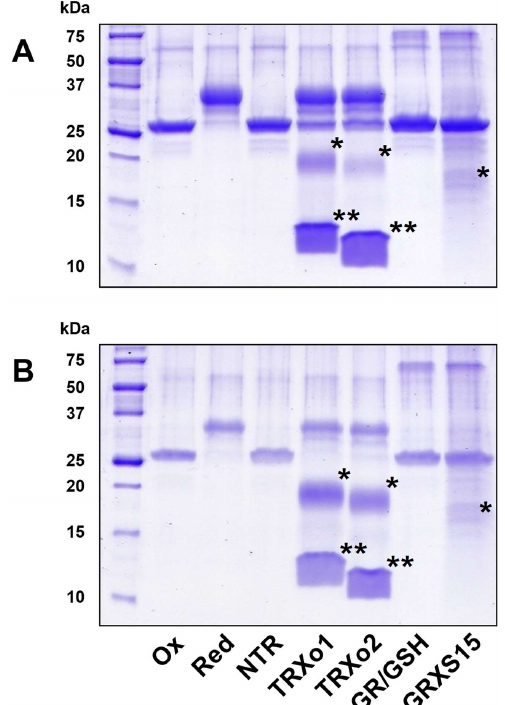
Figure 6. The disulfide bridge of mitochondrial NFUs (nitrogen-fixation-subunit-Us) is reduced by TRXs o but not GRXS15. The reduction of as-purified, oxidized forms of NFU4 ( A ) or NFU5 ( B ) was assessed after a 15 min incubation in the presence of the following reducing systems: NTR: NADPH + NTR; TRXo1: NADPH + NTR + TRXo1; TRXo2: NADPH + NTR + TRXo2; GR/GSH: NADPH + GR + GSH ; GRXS15: NADPH + GR + GSH + GRXS15. After alkylation with 2 kDa mPEG maleimide, proteins were separated on non-reducing SDS-PAGE (sodium dodecyl sulfate polyacrylamide